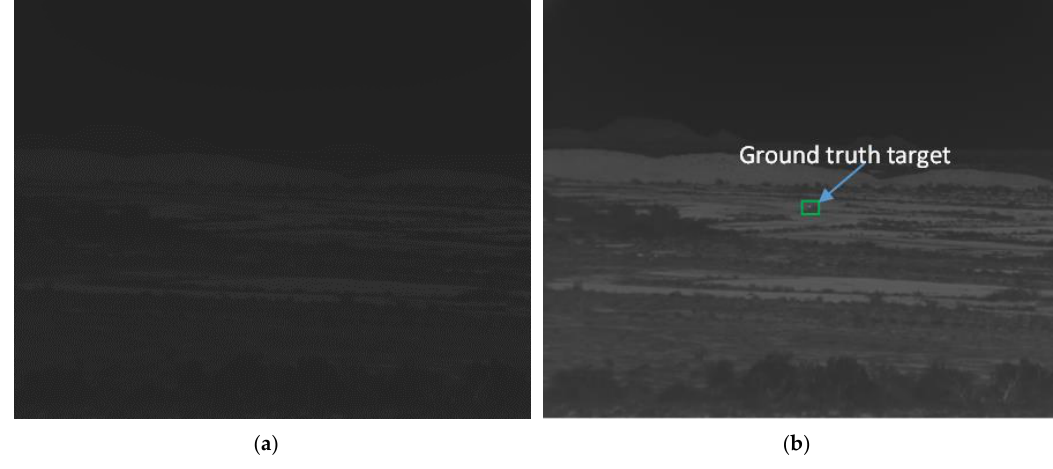
Figure A6. Before and after comparison of Approach 4. ( a ) Raw image; ( b ) Contrast-enhanced image.